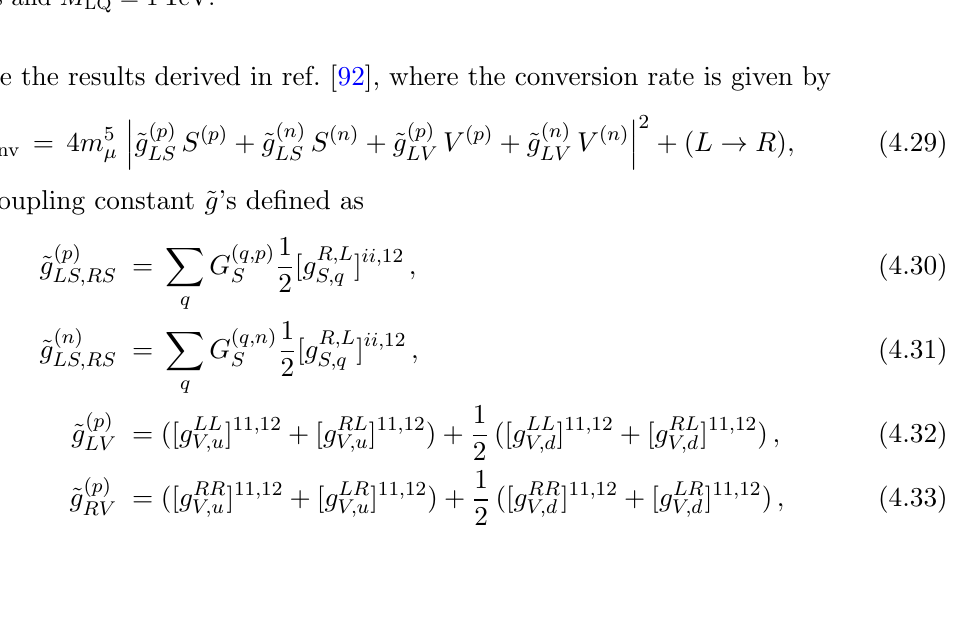
Table 6 . Coe(cid:14)cients of the constrained equation (4.27), arising from ‘ ! ‘ 0 ‘ 0 ‘ 00 , for all (cid:12)ve scalar leptoquarks and M LQ = 1